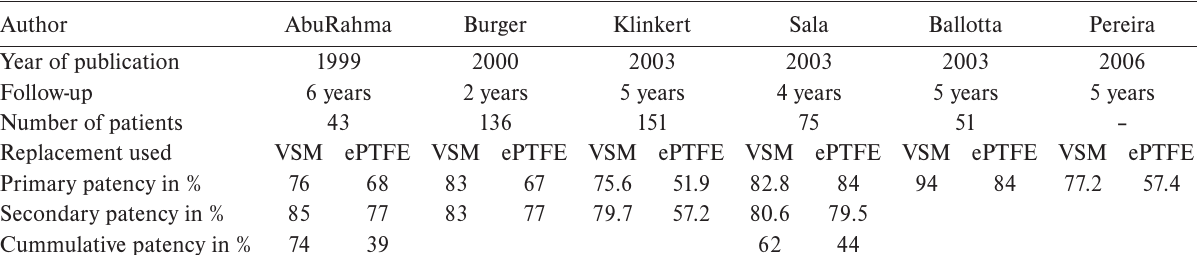
Table 1. Results of FP bypass – comparison between autologous vein (VSM) and ePTFE